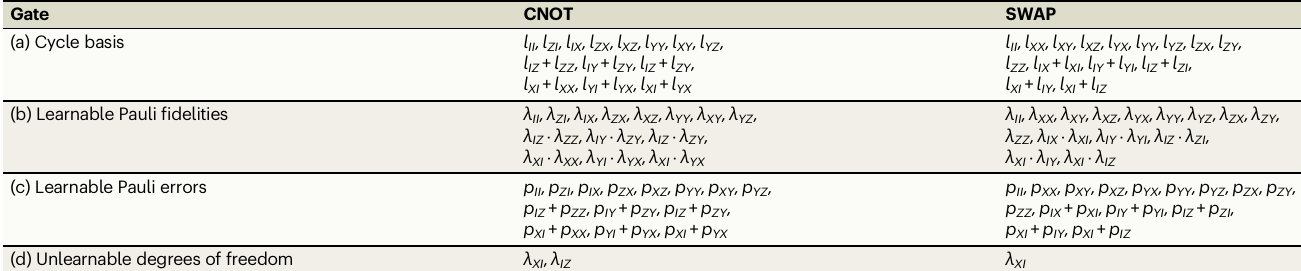
Fig. 2 | Pattern transfer graph of CNOT, SWAP, and a gate set consisting of CNOT and SWAP. Here, multiple edges are represented by a single edge with multiple labels. The labels on the fi rst two graphs are gate dependent, though we